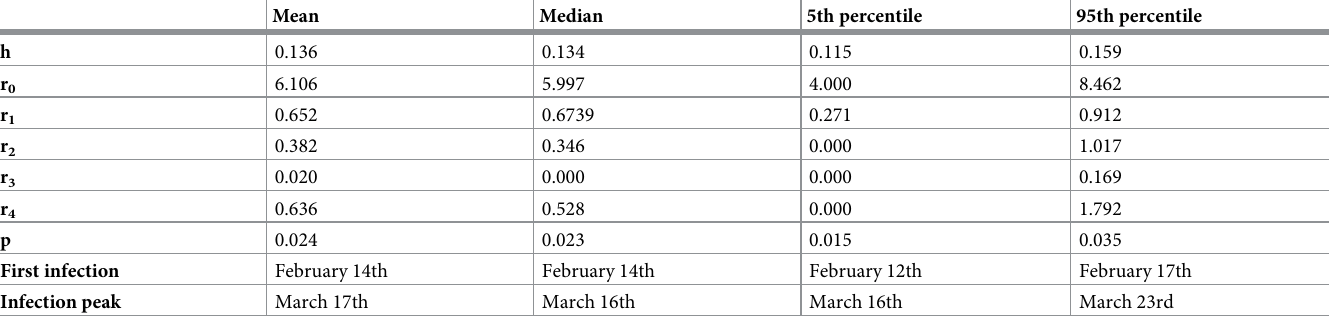
Table 5. Mean, median, 5th, and 95th percentiles of the model outputs as the inputs vary.